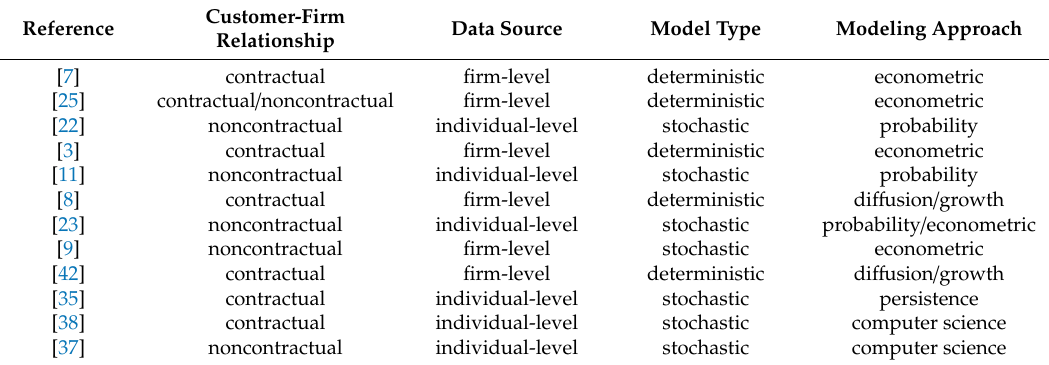
Table 1. Examples of customer equity (CE)